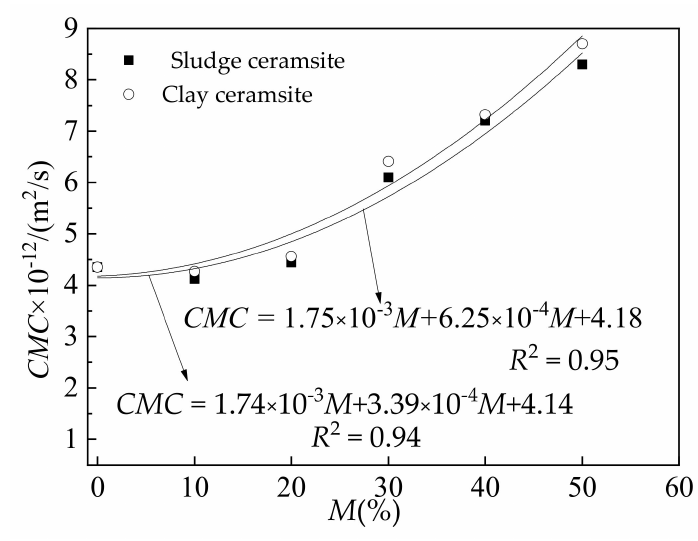
Figure 8. Chloride migration coefficient (CMC) of ceramsite cement concrete.